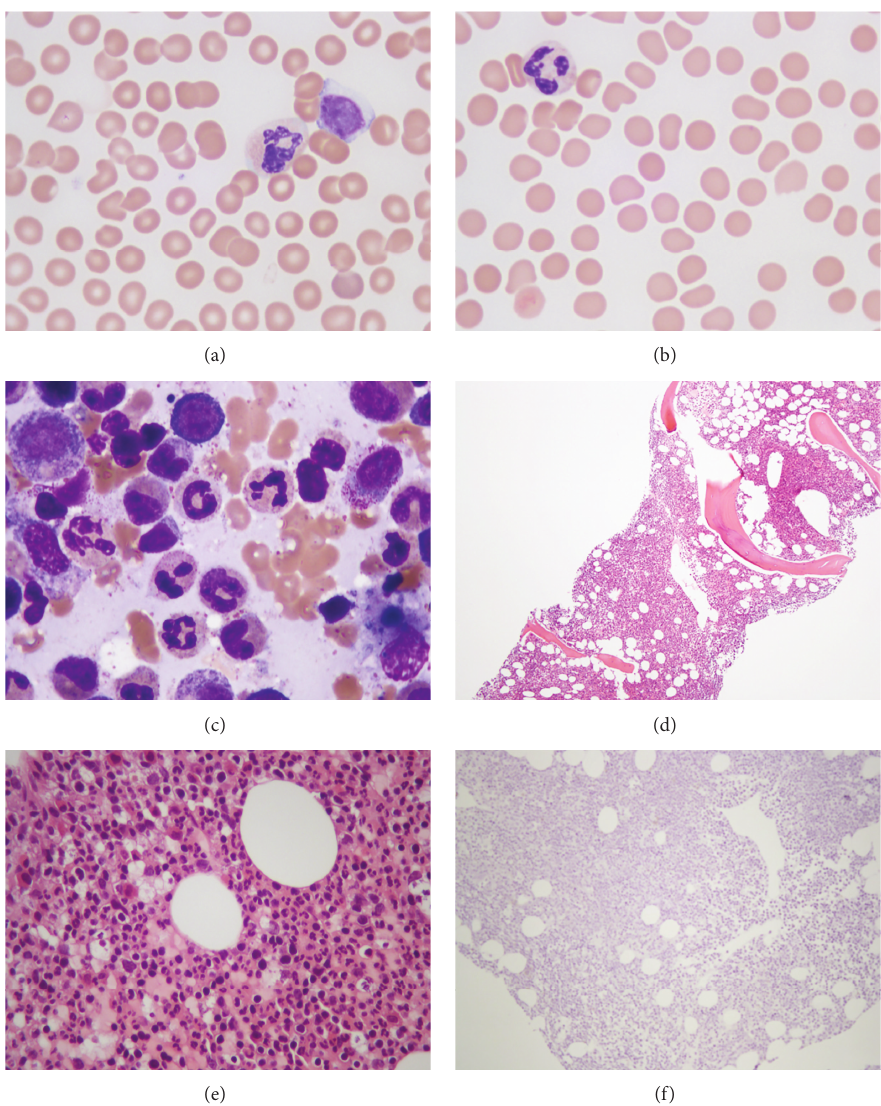
Figure 1: ((a)-(b)) The peripheral blood shows normal mature neutrophils and lymphocytes with normal red blood cell morphology. Rare morphologically normal platelets are identified. (c) The bone marrow aspirate shows a spectrum of normal maturation in erythroid and granulocytic precursors. No abnormal cell population is identified. (d) The bone marrow core biopsy cellularity is appropriate for age. (e) The bone marrow interstitium does not show the presence of megakaryocytes. (f) Immunohistochemistry for CD61, a megakaryocytic antigen, does not show the presence of megakaryocytes on the core biopsy tissue